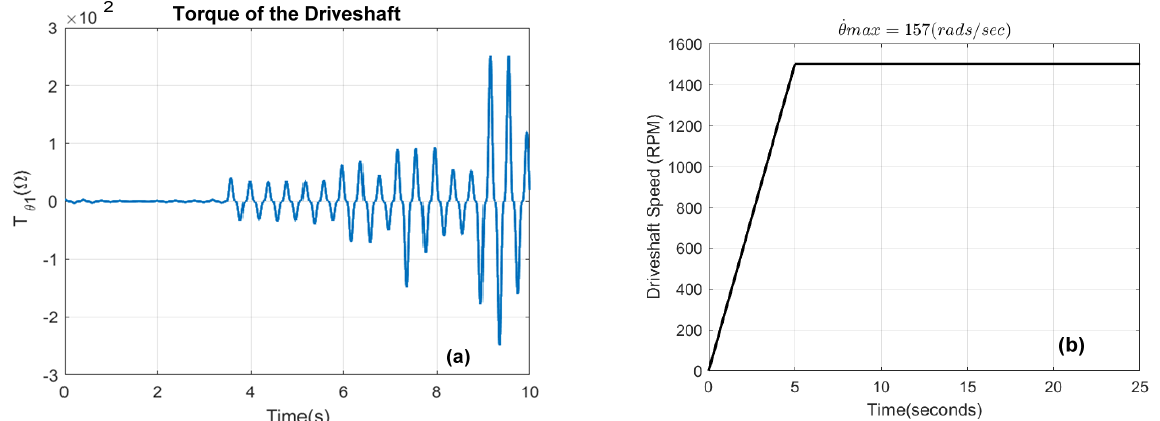
Figure 6. Motor torque fluctuation ( a ) torsional torque transmitted to the driveshaft ( b ) driveshaft speed profile at a maximum speed of 1500 rpm.